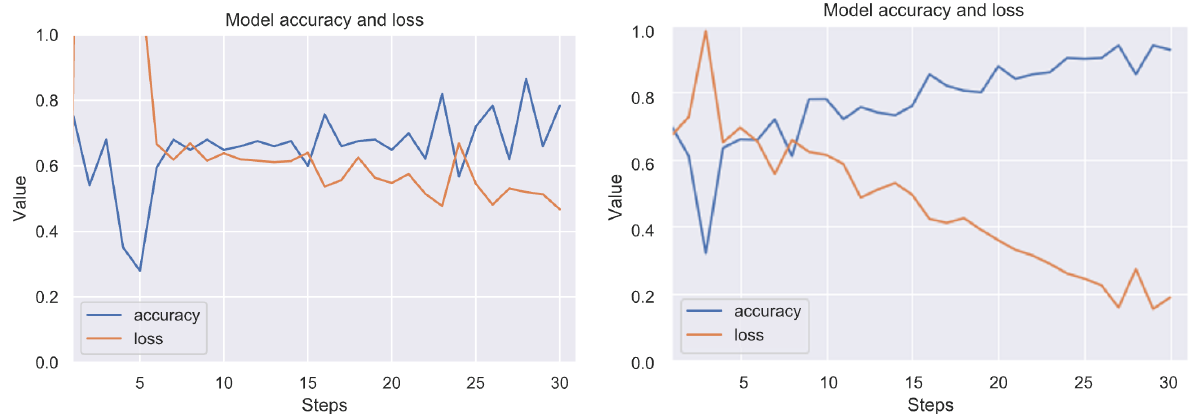
Figure 6. Exemplary learning effect before ( left side) and after using our technique ( right side). Results for the RIYADH dataset. Class ok (without artifacts) vs. class er (with strong artifacts). The line graphs show accuracy (blue) and loss (orange) for 15 epochs (30 steps from batch). Although the image dataset is relatively small for the convolutional neural network (CNN), a good trend in increasing accuracy while minimizing loss can be observed.